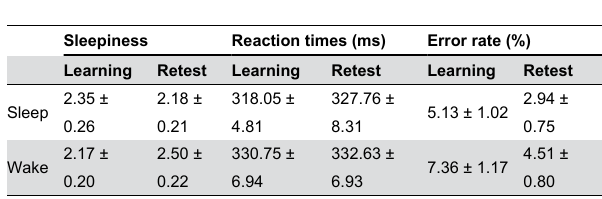
Table 1. Sleepiness and vigilance performance.